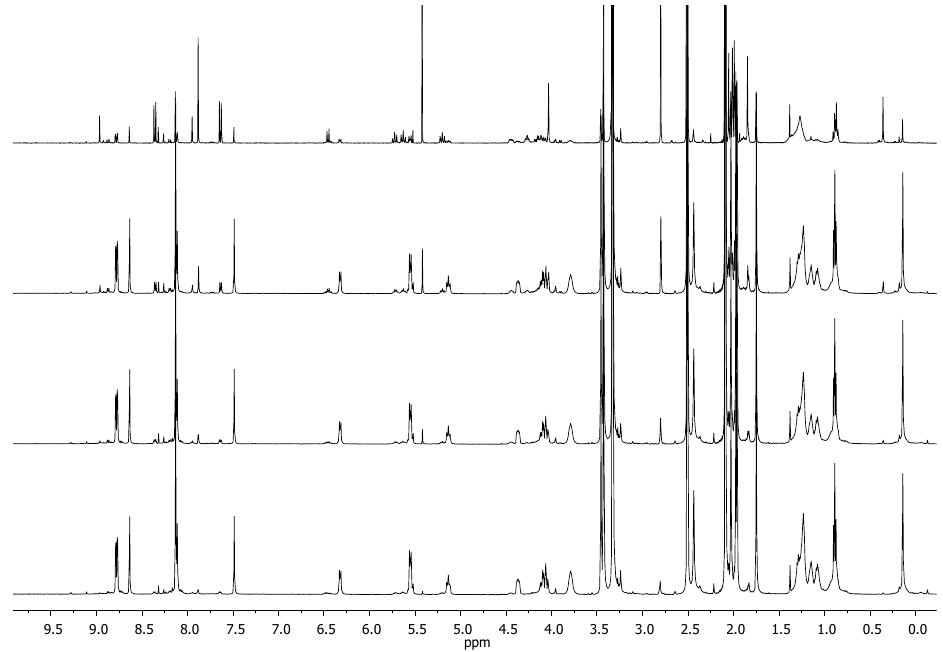
Figure 6. The 1 H NMR spectrum of 1-Me,Oct in DMSO-d 6 after dissolution (bottom), 1.5, 5, and 24 h (up).